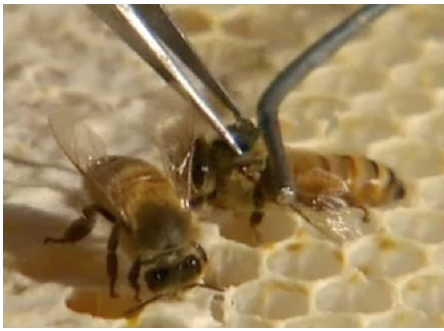
Figure 3. RFID tag being fitted to the thorax of a honey bee. This process can be done in the hive with non-aggressive